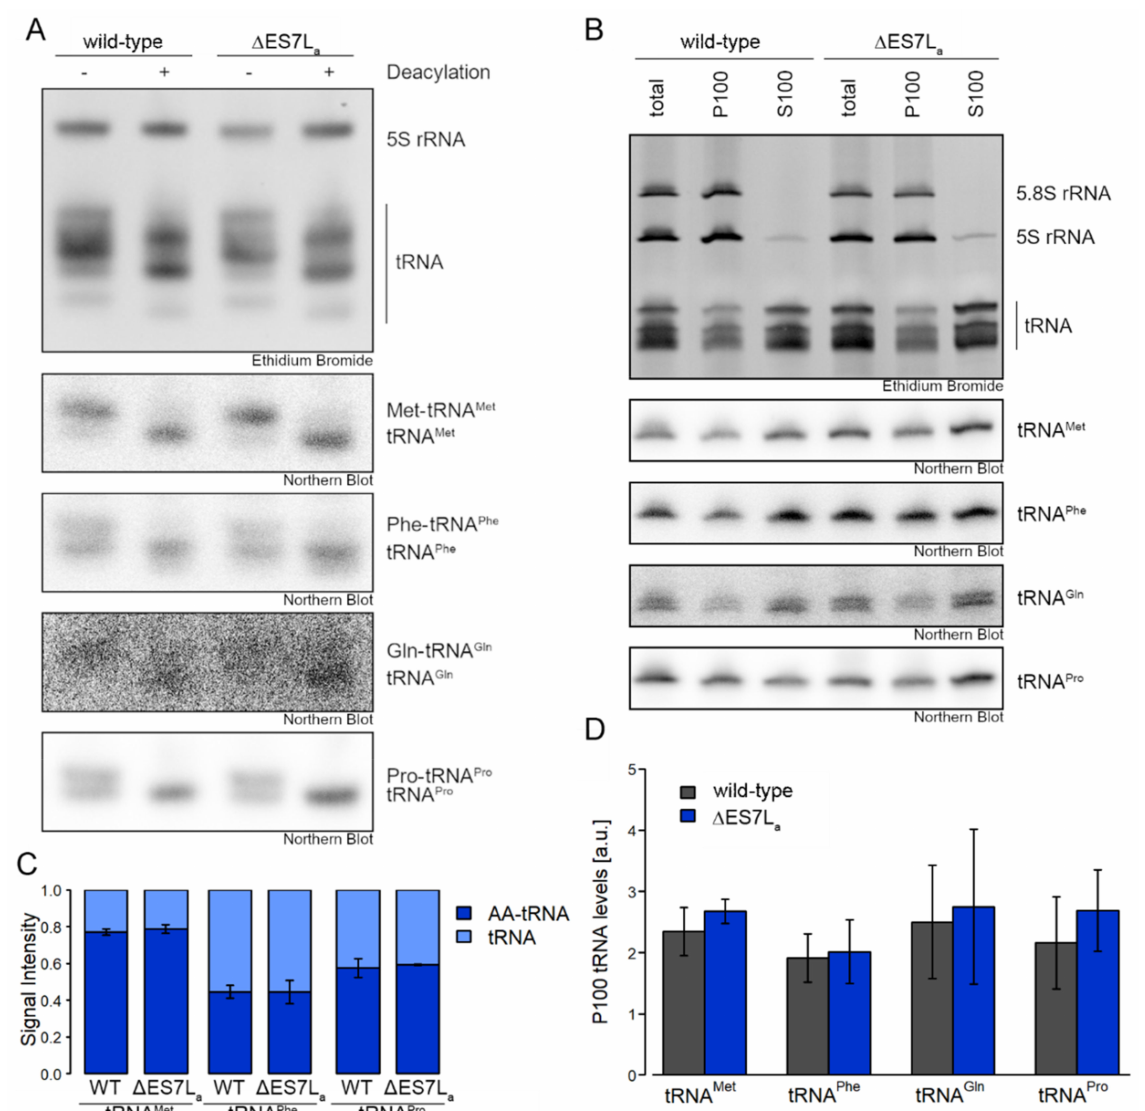
Figure 4. Acidic gel and P100/S100 northern blots. ( A ) Separation of aminoacylated and deacylated tRNA was performed by acidic polyacrylamide gel electrophoresis. Four tRNAs were detected by northern blot. For each RNA sample a deacylated control was included. ( B ) Quantification of signal intensities of the charged and uncharged tRNA in A (three biological replicates). ( C ) WCL was fractionated to ribosome-enriched pellets (P100) and the corresponding supernatant (S100) by centrifugation and tRNAs detected by northern blot. ( D ) Quantification of signal intensities of P100 tRNA levels normalized to 5S rRNA levels in the ethidium bromide staining in ( C ) (three biological